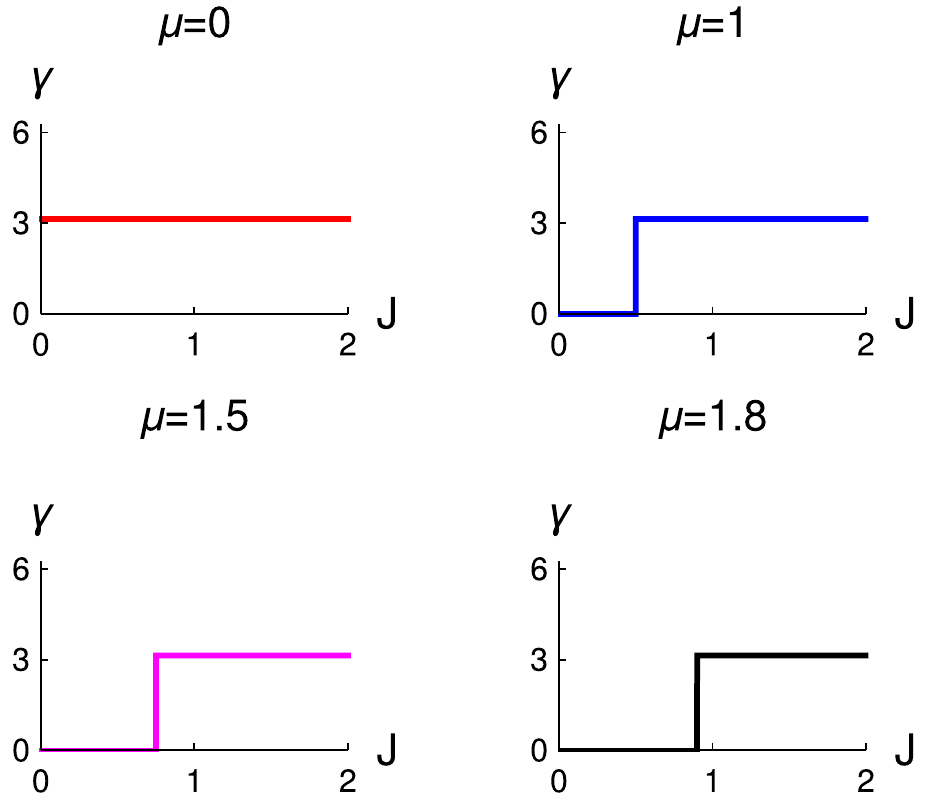
Figure 4. The variation of Zak phase ( γ ) with J for different values of μ . We study for the four different values of chemical potentials μ = 0( red ), 1( blue ), 1.5( magenta ), 1.8( black ), Δ =